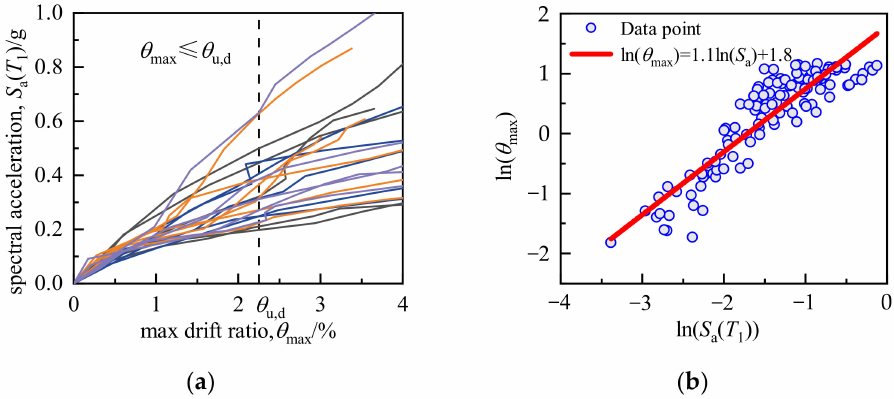
Figure 6. IDA curves and regression analysis of the results. ( a ) The IDA curves of column Ang. No.3 in the extreme damage state. ( b ) Regression analysis based on IDA